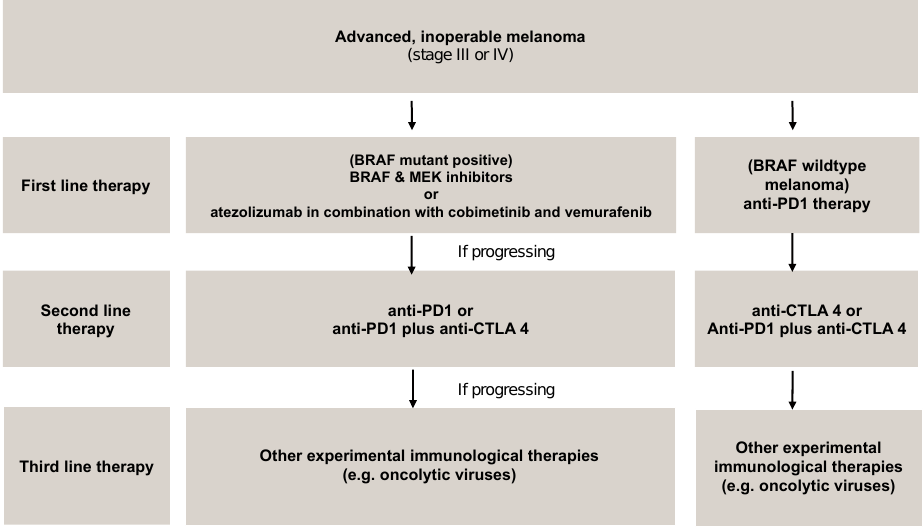
Figure 3. CPI refractory melanoma-treatment scheme overview.